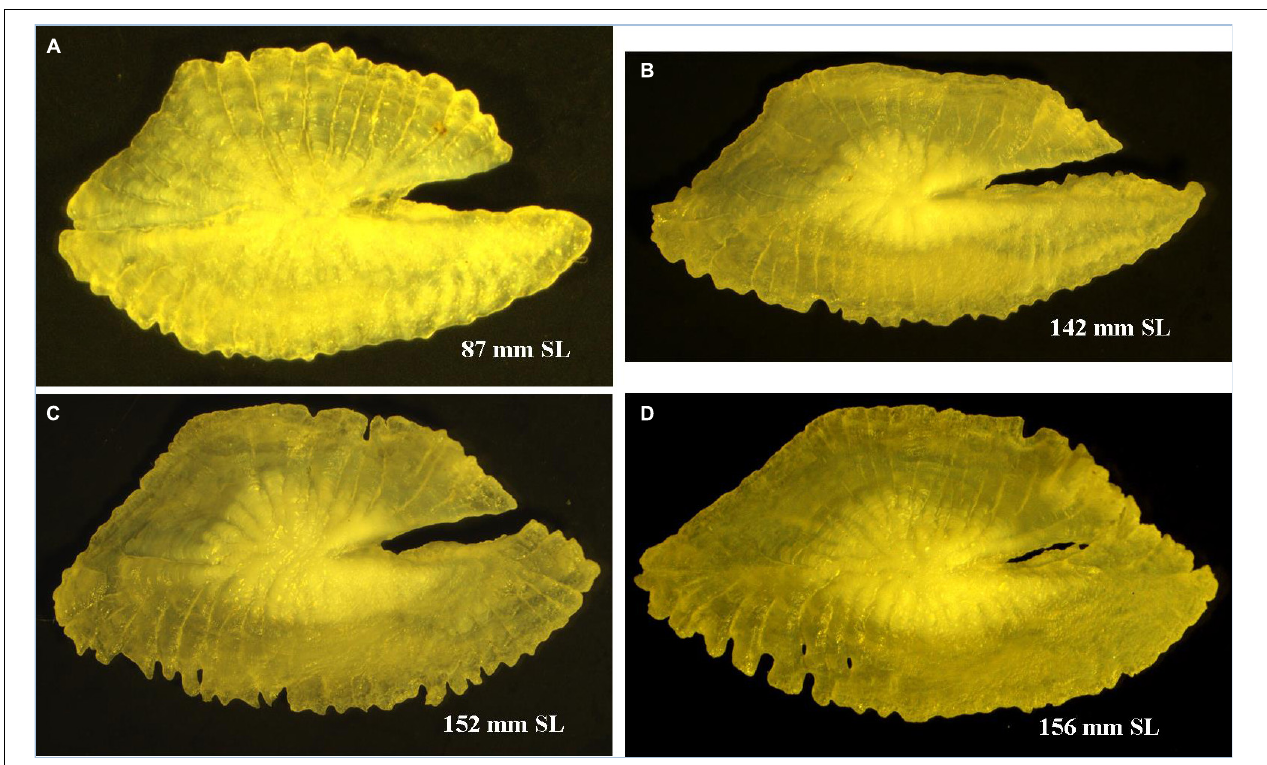
FIGURE 5 | Pampus candidus . (A) Sagittal otolith of juvenile and (B–D) adult specimens.